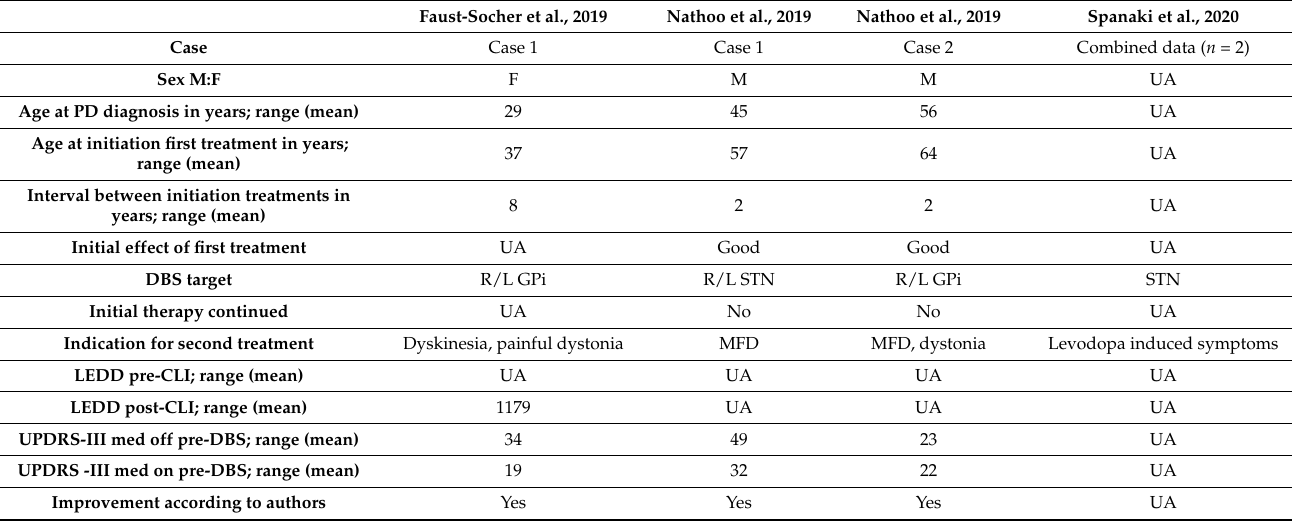
Table A4. Characteristics of patients firstly treated with CLI, DBS as second treatment—reported in